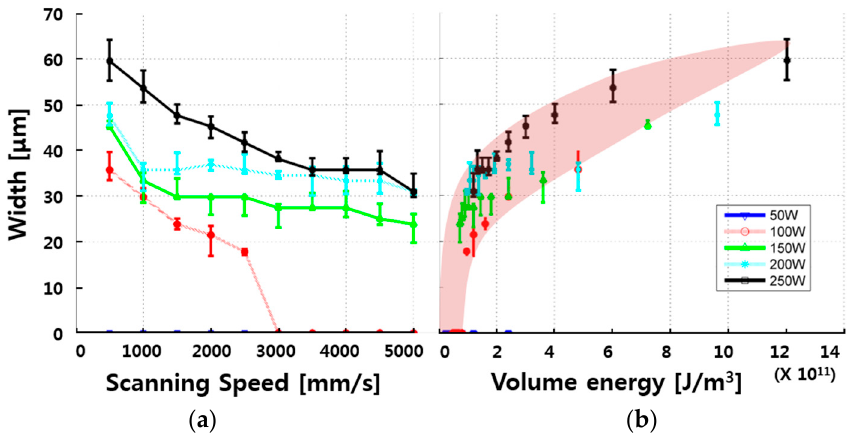
Figure 5. ( a ) Kerf width VS. Scanning speed; ( b ) Volume energy.